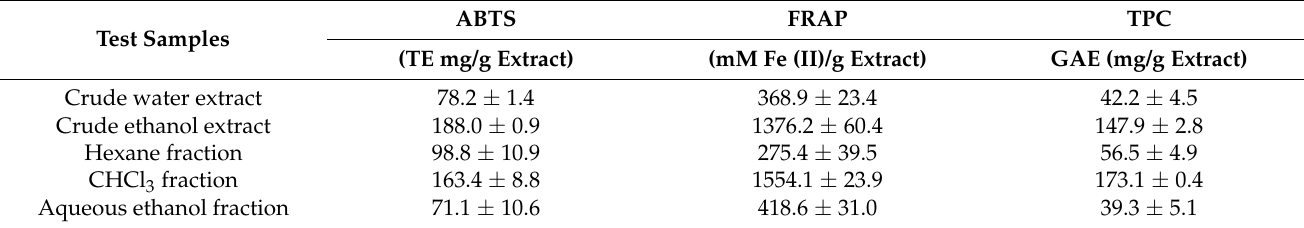
Table 3. Antioxidant properties of L. martabanica root extracts in ABTS assay, FRAP assay, and TPC assay. Test Samples